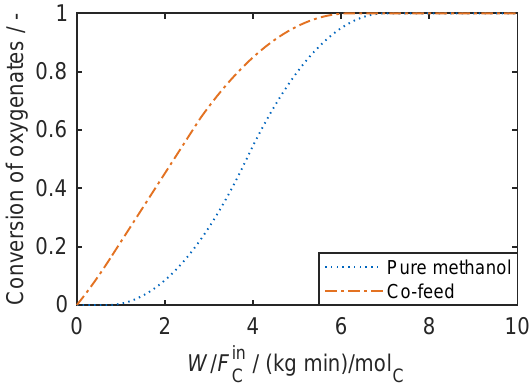
Figure 4. Typical case of oxygenates conversion as a function of contact time for a pure methanol feed and for a feed comprising olefins co-fed with